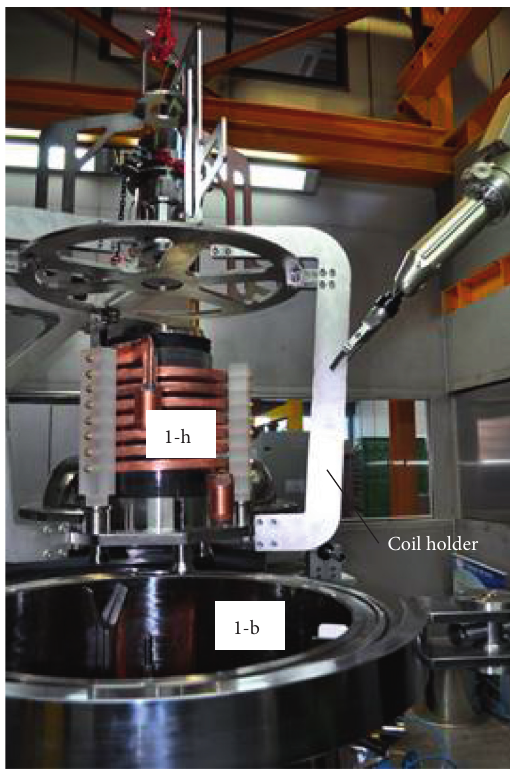
Figure 5: Example of remote maintenance pretest: removing a damaged induction coil from the interior of the lower chamber using a coil holder, a crane, and MSMs (booting removed) at mock- up facility before installation in